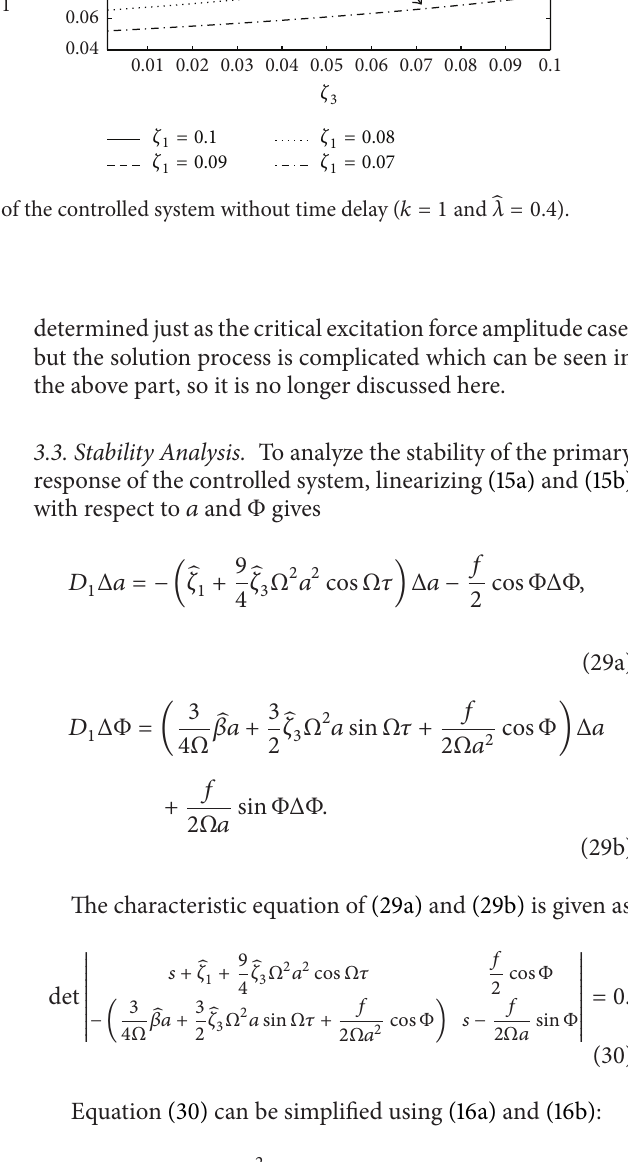
Figure 8: Critical surface and contours of the critical surface of the controlled system without time delay ( 𝑘 = 1 and